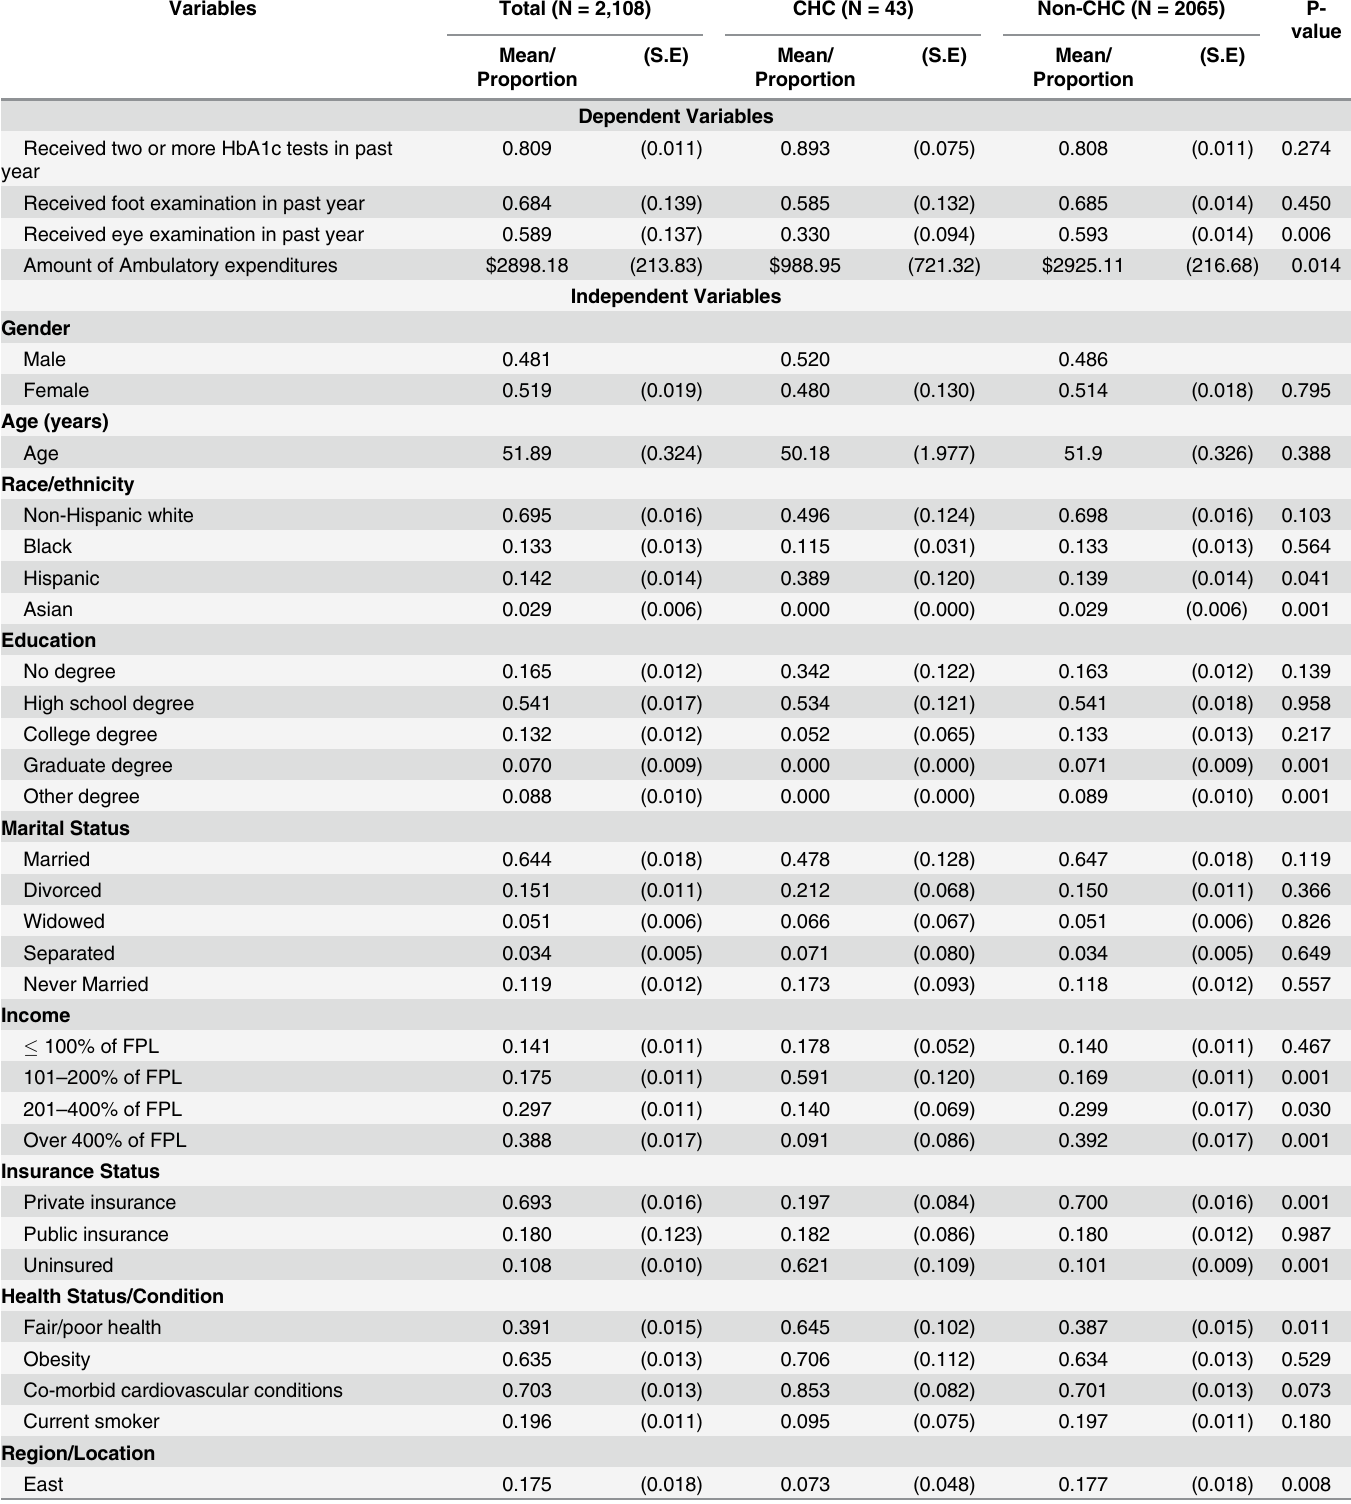
Table 1. Weighted Means/Proportions of Dependent and Independent Variables Used in the Models (N = 2,108), MEPS 2005 –